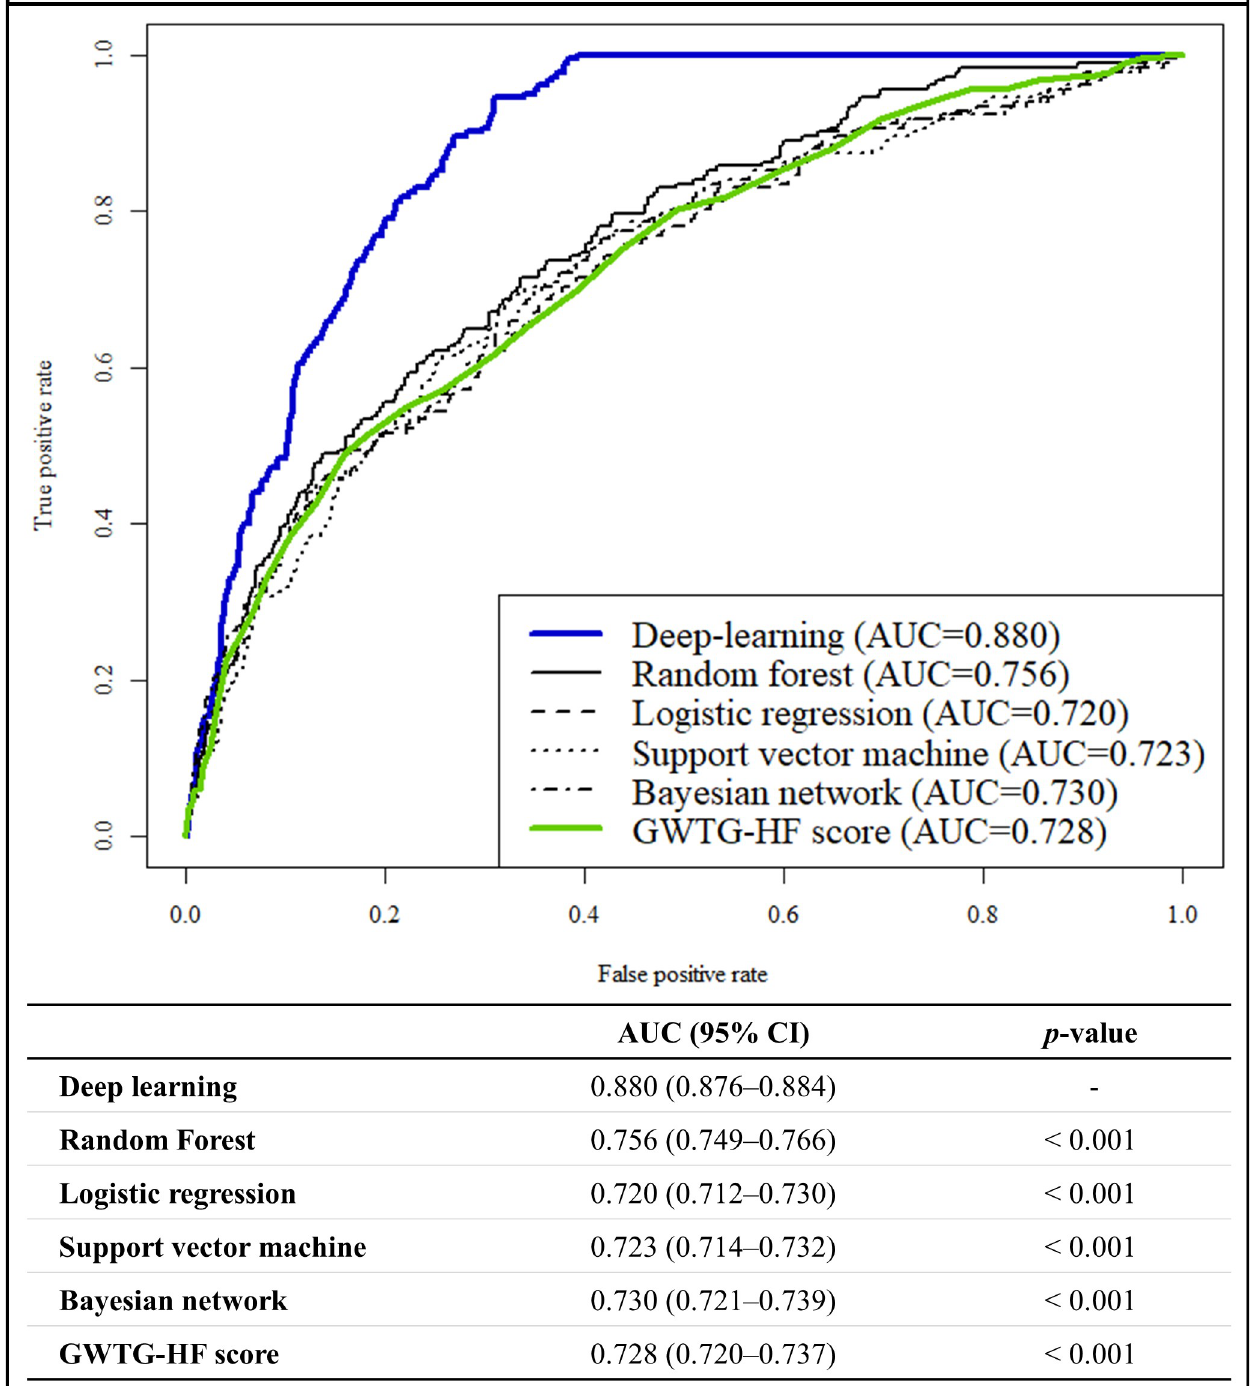
Fig 3. Receiver operating characteristic curve for predicting in-hospital mortality. AUC, area under the receiver operating characteristic curve; CI, confidence interval; GWTG-HF, Get with the Guideline–Heart Failure.